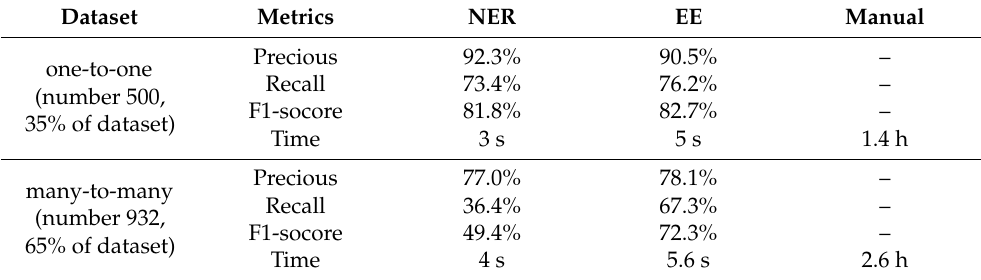
Table 13. FP recognition and classification results on different